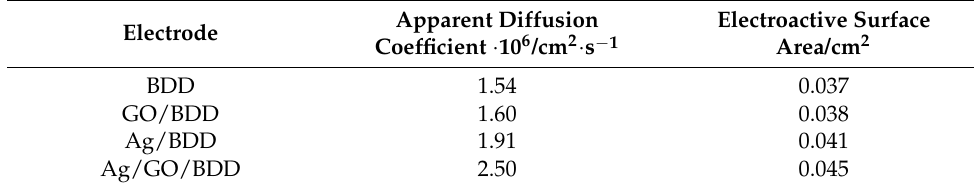
Figure 1. Scanning electron microscopy (SEM) images of: silver/boron-doped diamond (Ag/BDD)( a );silver/graphene oxide/boron-doped diamond(Ag/GO/BDD)( b ); energy-dispersive X-ray spectroscopy (EDX) images of Ag/BDD ( c ); Ag/GO/BDD ( d ). Table 1. Comparative apparent diffusion coefficient and electroactive surface